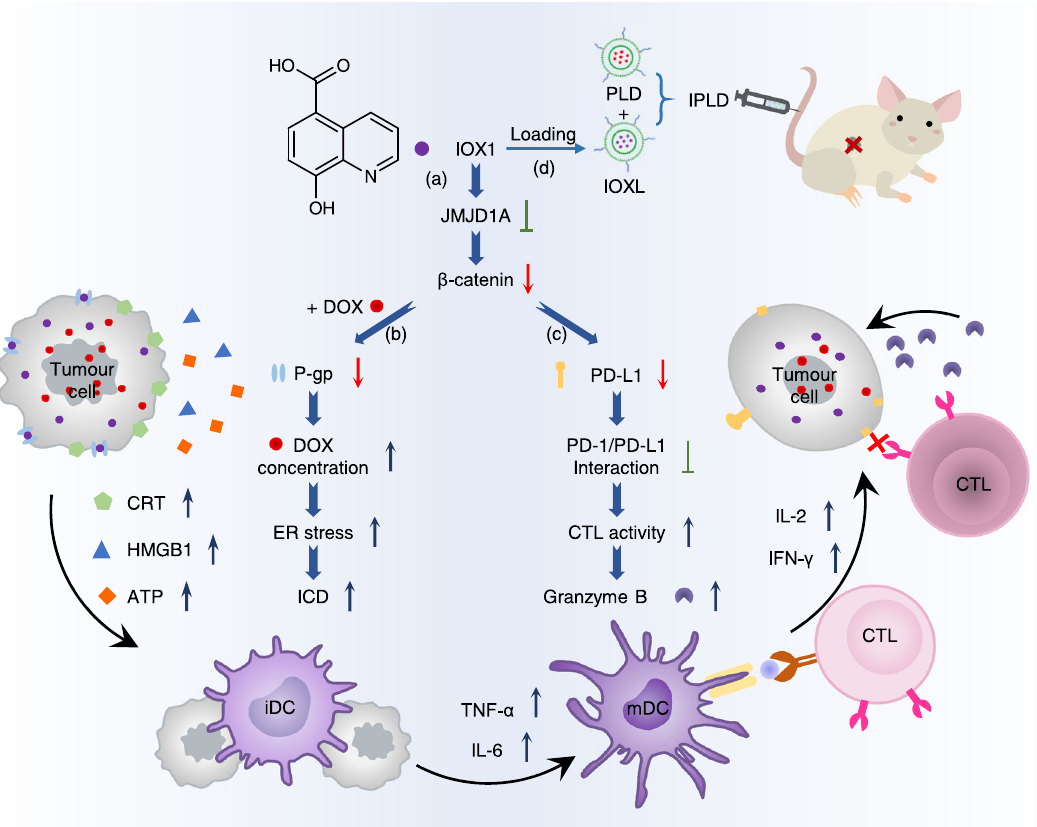
Fig. 1 5-Carboxy-8-hydroxyquinoline (IOX1) potentiates chemo-immunotherapy. a IOX1 inhibits the histone demethylase Jumonji domain-containing 1A (JMJD1A) and thus downregulates its downstream β -catenin expression; b it downregulates P-glycoproteins (P-gp) and increases doxorubicin (DOX) concentration of cancer cells, facilitating the immunogenic cell death (ICD); c it downregulates tumour cells ’ PD-L1 expression and thus disrupts the PD-1/ PD-L1 pathway with T cells. d The synergy of the two effects enables its liposome formula (IOXL) combined with pegylated liposomal DOX (PLD), i.e. IPLD, to inhibit tumour growth. ER: endoplasmic reticulum, CRT: calreticulin, HMGB1: high mobility group box 1, ATP: adenosine triphosphate, iDC: immature dendritic cell, mDC: mature dendritic cell, CTL: cytotoxic T